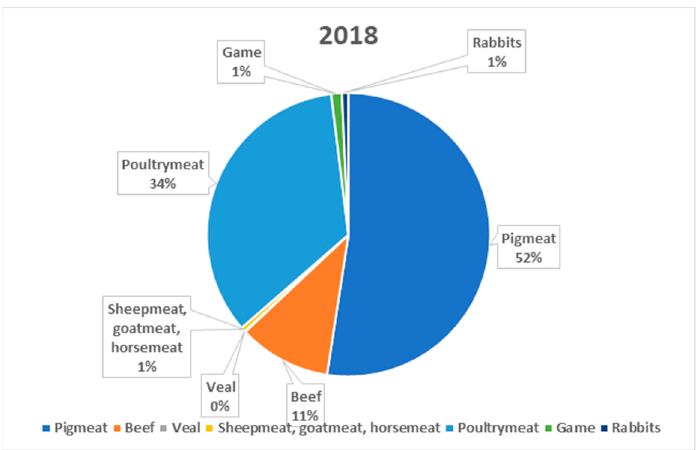
Figure 13. Share of meat consumption in 2018 [27].